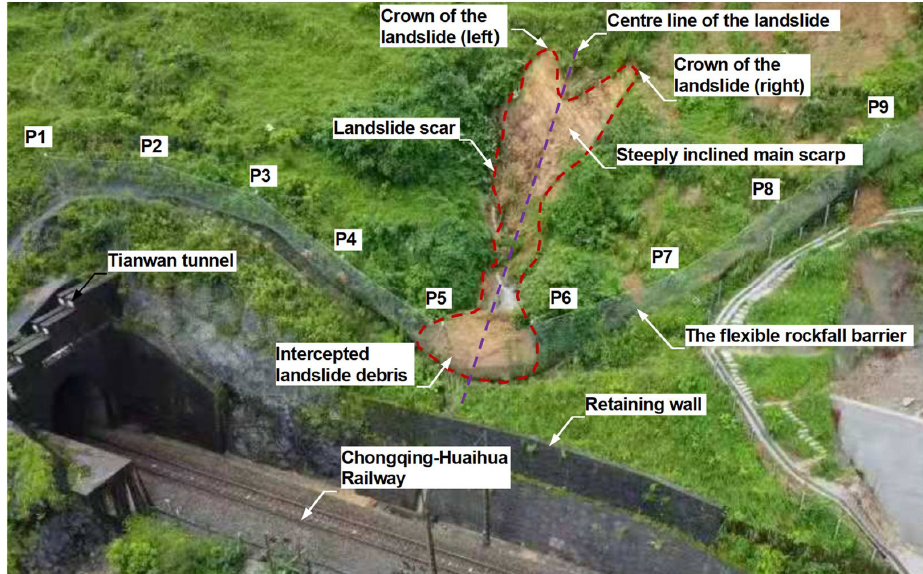
Figure 2. An overall view of the landslide site.